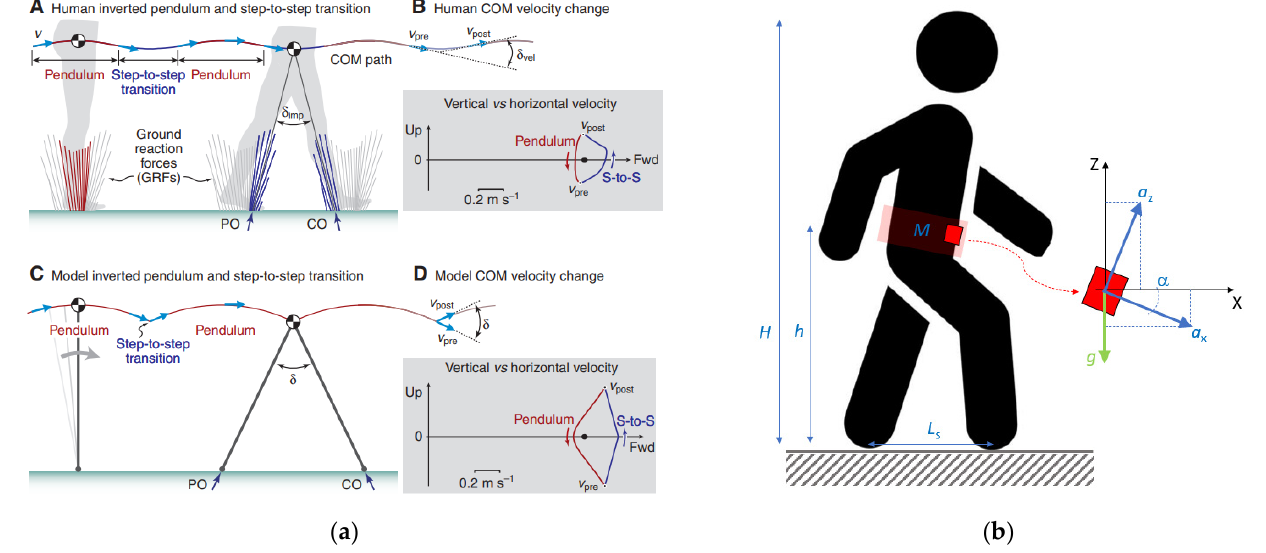
Figure 1. Experimental method: ( a ) reference literature pendulum model (figure reproduced from [17] with permission from The Company of Biologists ® , order number 1175262, January 2022) and ( b ) herein adopted measurement system for body CoM acceleration records, with detail of lumbar belt to keep in position the used Wi-Fi sensor.